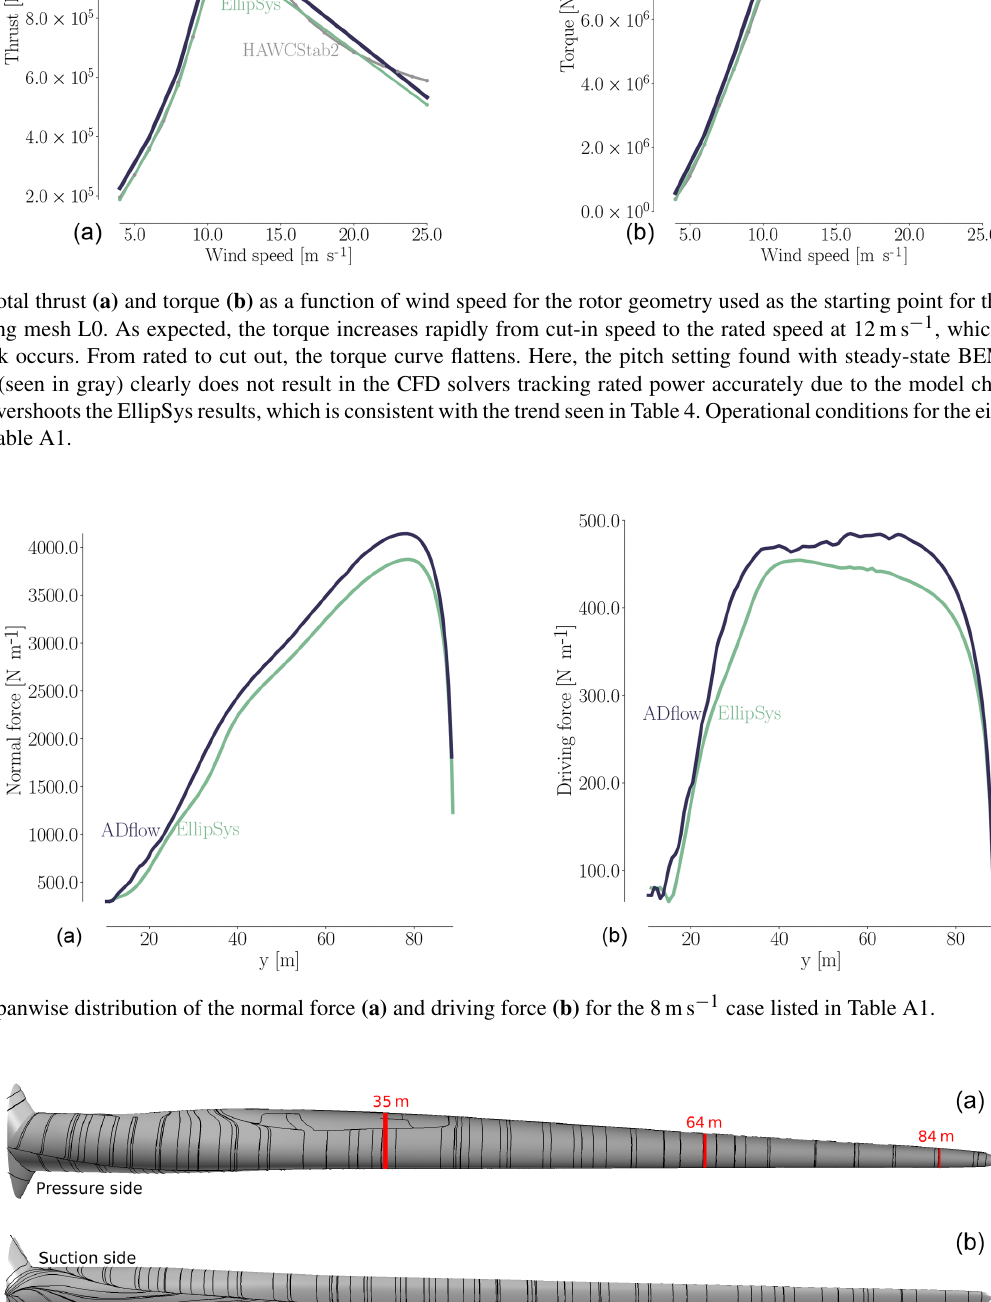
Wind Energ. Sci., 4, 163–192,